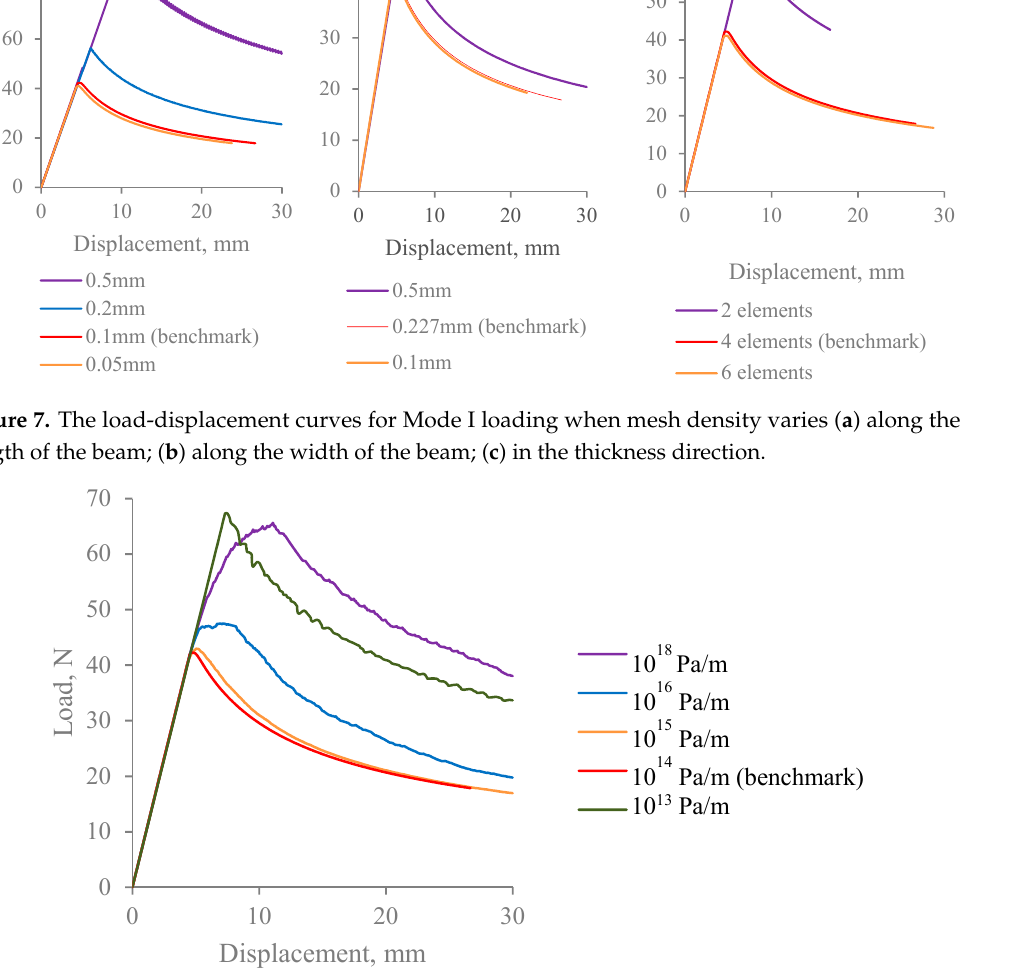
Figure 8. Sensitivity of load-displacement predictions to the normal interface